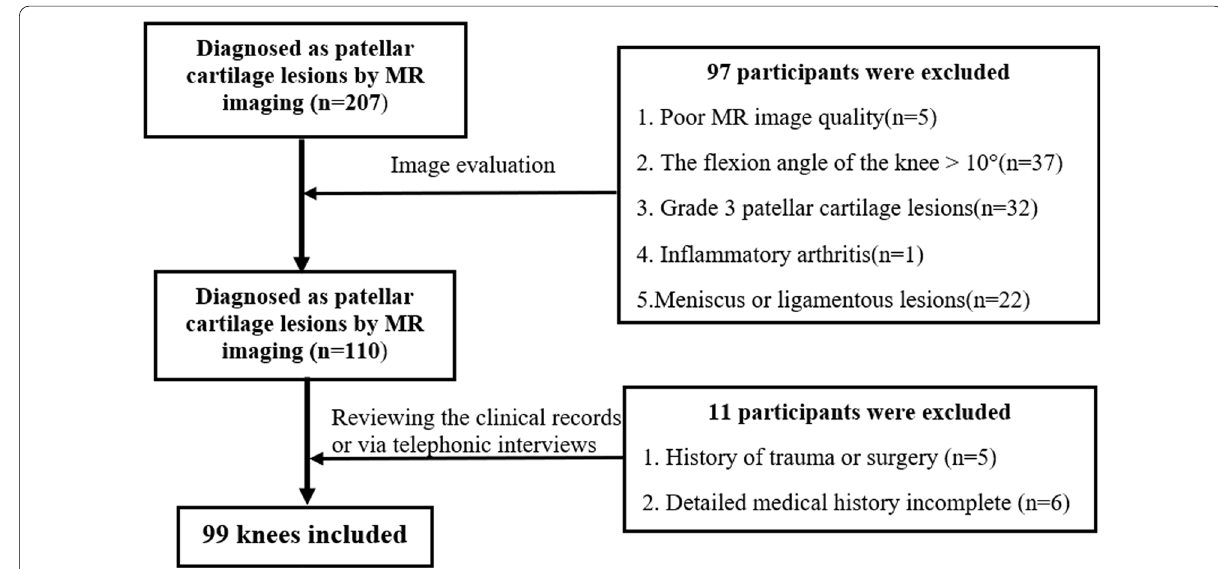
Fig. 1 Flowchart for selection of participants in patellar cartilage lesions